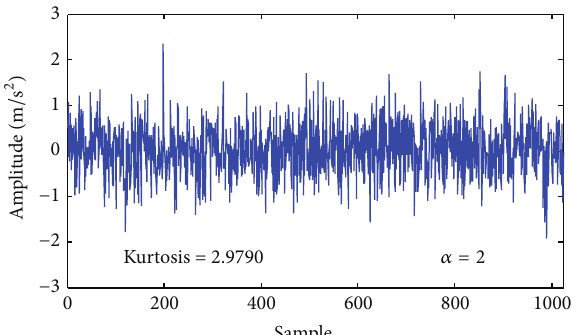
Figure 19: Gaussian signal with standard deviation 0.6.